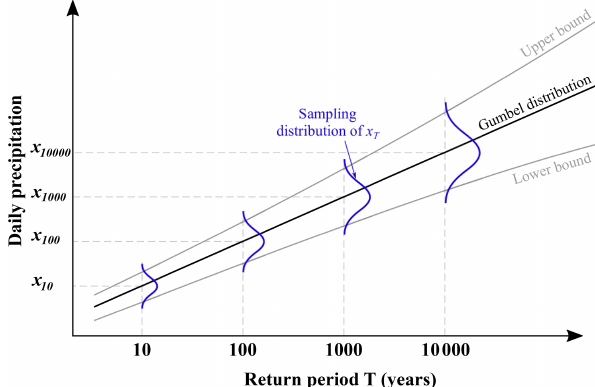
Figure A1. Uncertainty of estimated T year daily precipitation quantile due to sampling error (adapted from Kite, 1975).